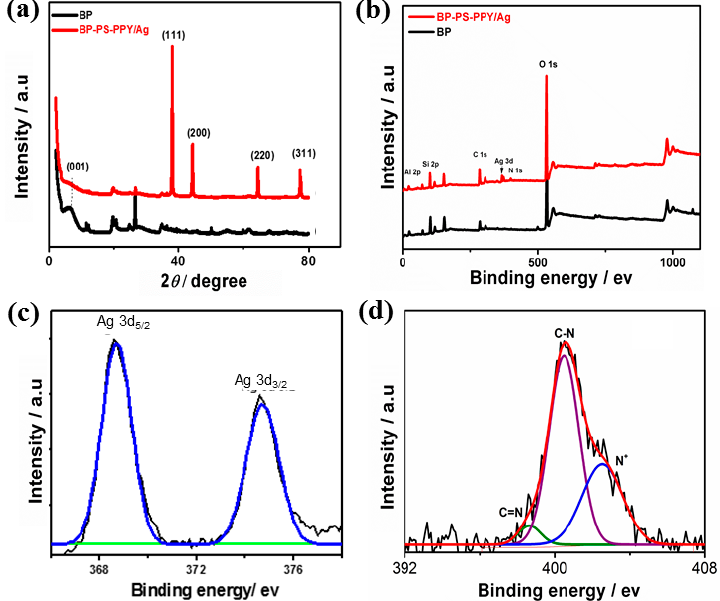
Figure 4. ( a ) Wide-angle X-ray di ff raction (XRD) patterns and ( b ) X-ray photoelectron spectroscopy (XPS) survey of BP-Ps-PPy / Ag and BP. ( c ) High-resolution XPS spectra of ( c ) Ag and ( d )